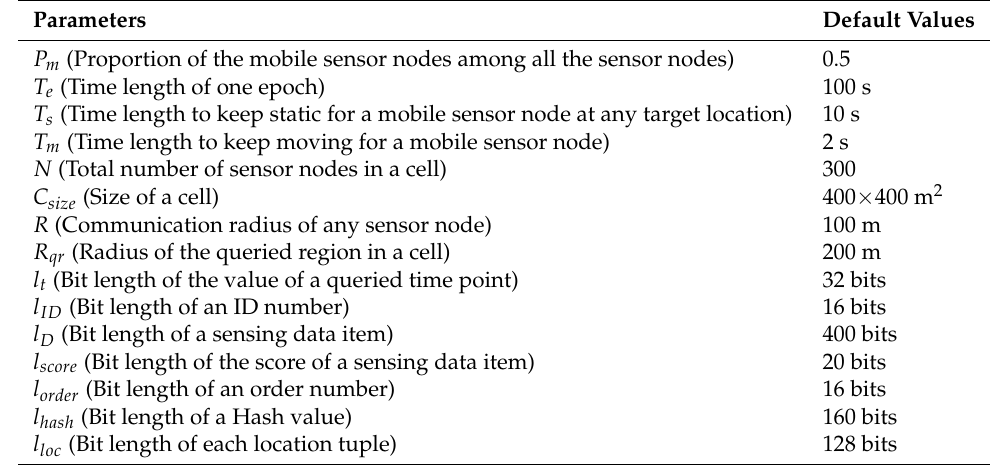
Table 1. Default parameter settings.